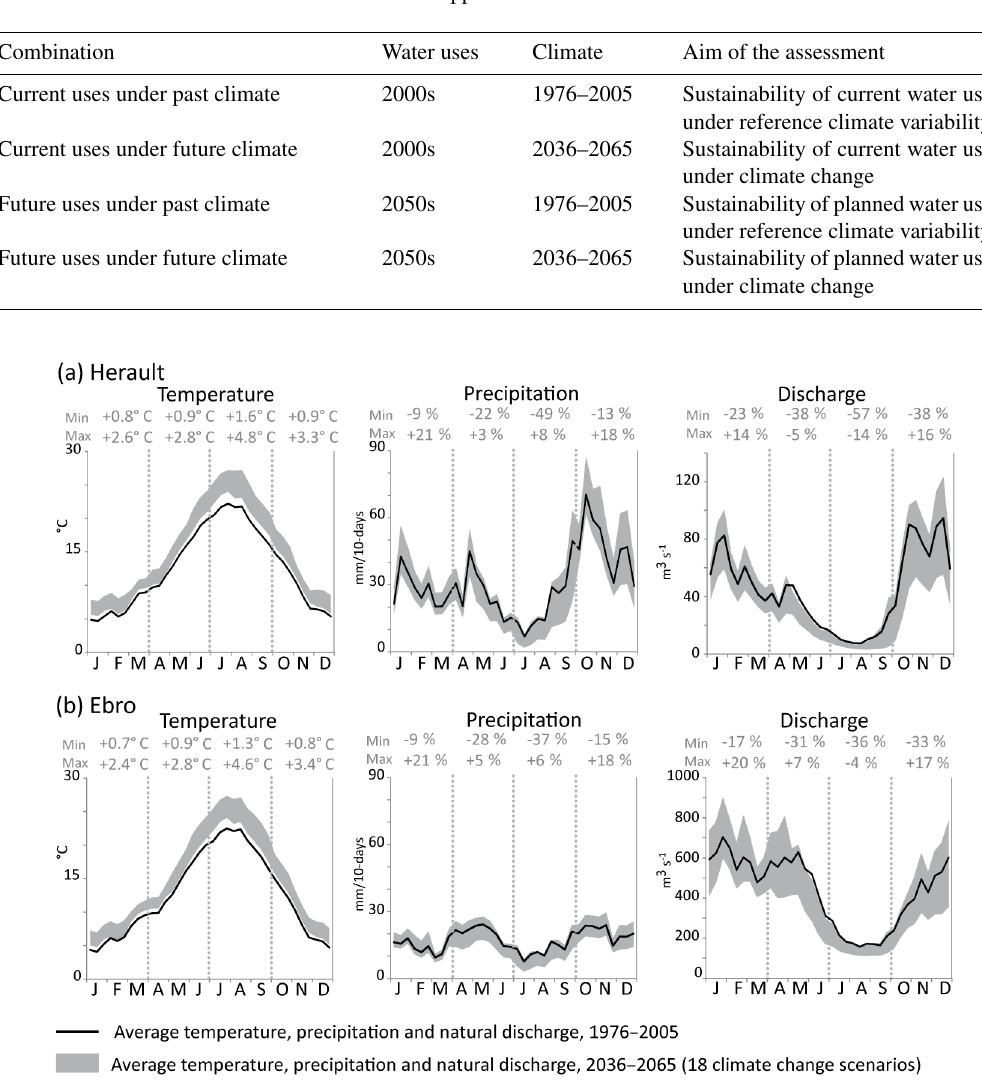
Figure 3. Average temperature, precipitation and natural discharge over the reference period 1976–2005 and under 18 climate change scenarios at the 2050 horizon in (a) the Herault and (b) the Ebro basins. Natural discharge is simulated with the hydrological model over the reference and future period. Modified from Fabre et al.